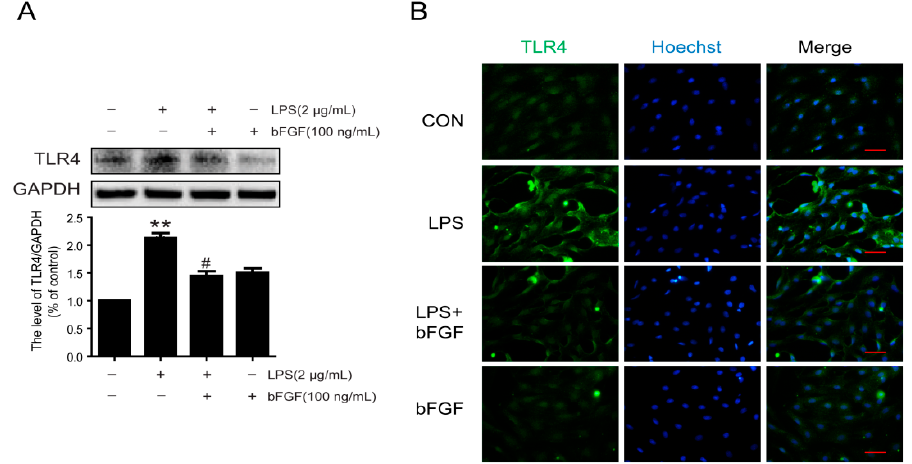
Figure 6. Effect of bFGF on expression of TLR4 in LPS stimulated astrocytes. Cells were incubated in the presence of LPS (2 µg/mL) with or without bFGF (100 ng/mL) for 24 h. ( A ) Western blot of TLR4 and densitometric analyses; ( B ) Immunofluorescence of TLR4 (green), the nuclear is labeled by Hoechst (blue). ** p < 0.01 versus CON, # p < 0.05 versus LPS. All results represent at least three independent experiments; Scale bar is 50 µm.